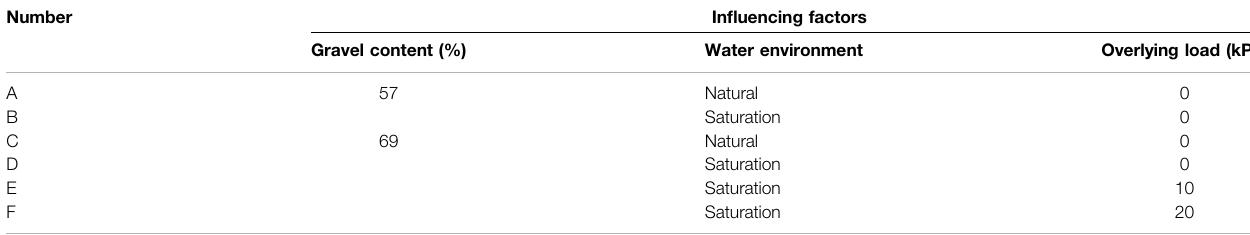
TABLE 1 | In-situ horizontal push-shear test of clay-gravel